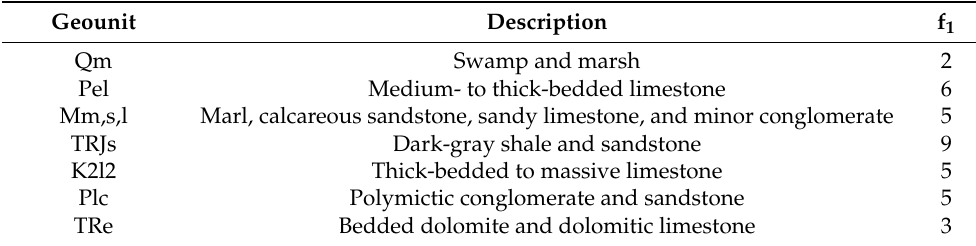
Table 1. Surface geology factor scoring.